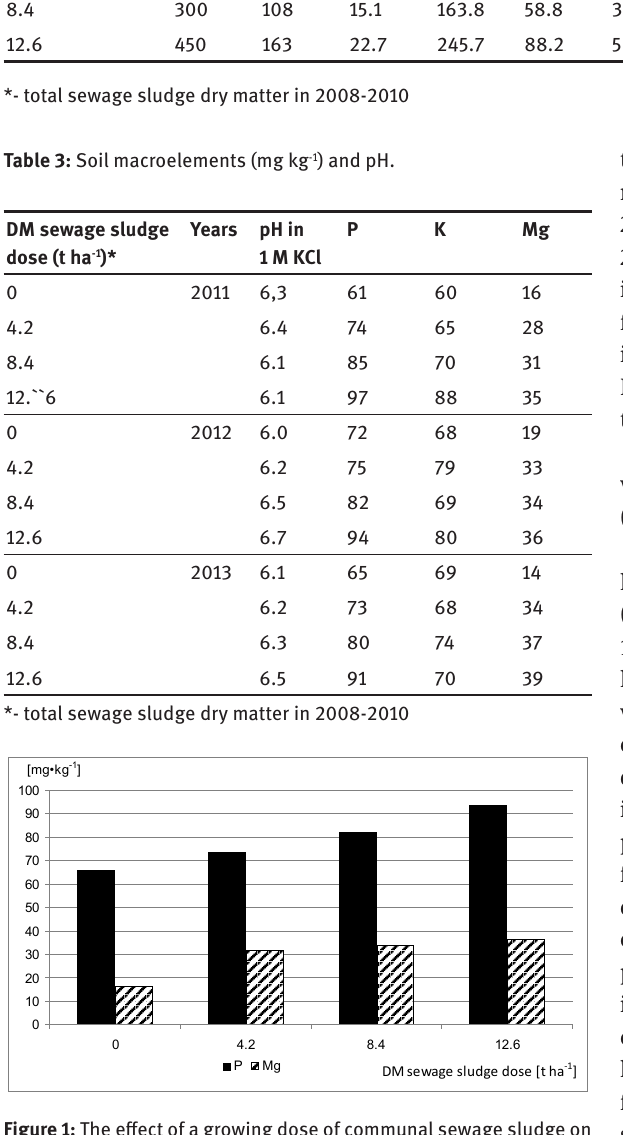
DM sewage sludge dose (t ha -1 )*